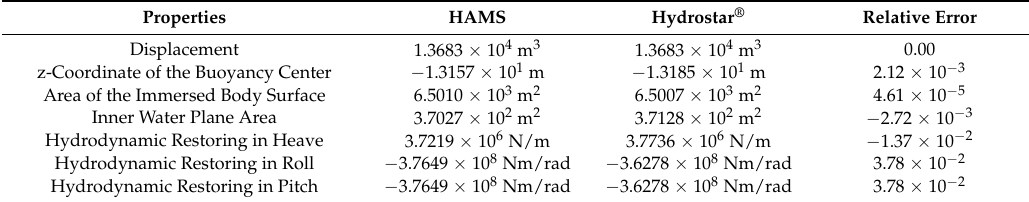
Table 3. Hydrostatic properties of the OC4 DeepCwind floater calculated by HAMS and Hydrostar ®.